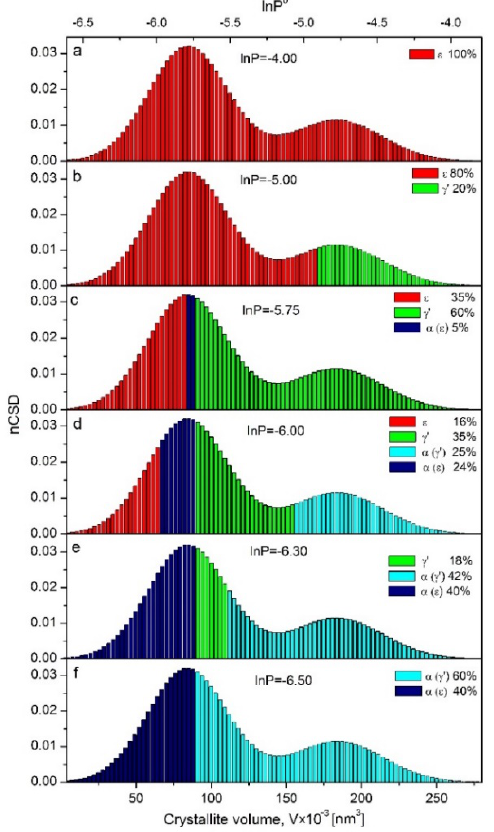
Figure 6. The dependence of sample phase composition on crystallite volume and nitriding potential during the reduction process at its various stages ( a – f ).